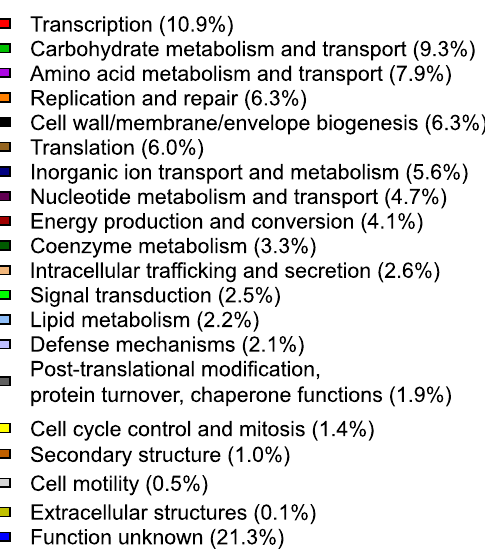
Figure 4. Functional categorization of 2860 predicted open reading frames (ORFs) in the genome of L. plantarum ATCC 202195-A based on Clusters of Orthologous Groups of proteins (COGs). Image was generated in Graphpad 9.